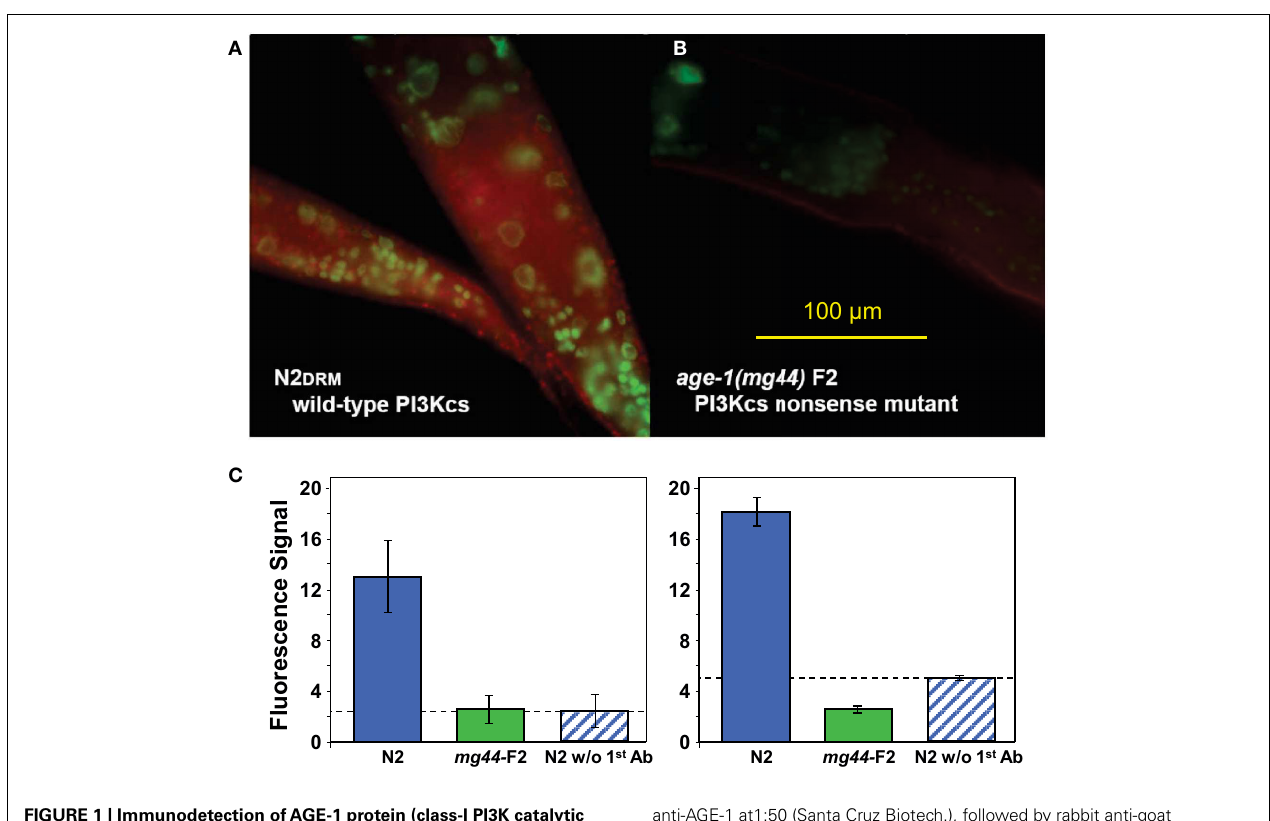
FIGURE 1 | Immunodetection ofAGE-1 protein (class-I PI3K catalytic subunit) in adult C. elegans of wild-type strain N2DRM (A) or second-generation age-1 ( mg44 ) homozygotes at adult age 3 days (B). Synchronized worms, fixed 14h in 1% formaldehyde at 4˚C, were permeabilized by successive exposures to 1% β -mercaptoethanol, 10-mM DTT, and 0.3% hydrogen peroxide. Primary antibody was goat